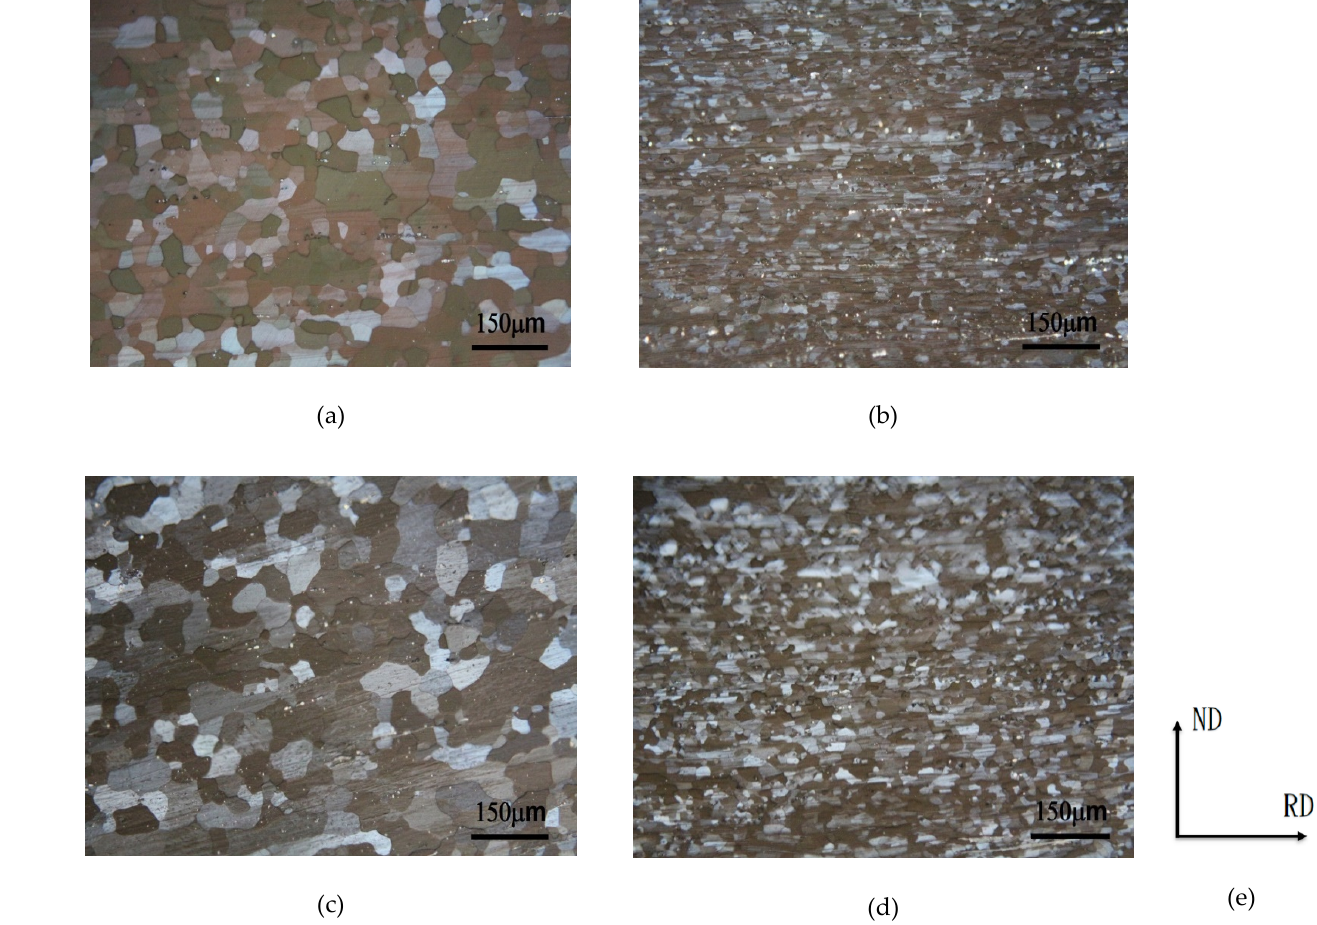
Figure 4. Observation after full annealing ( a ) 1-Homo Alloy A; ( b ) 2-Homo Alloy A; ( c ) 1-Homo Alloy B; ( d ) 2-Homo Alloy B; ( e ) rolling